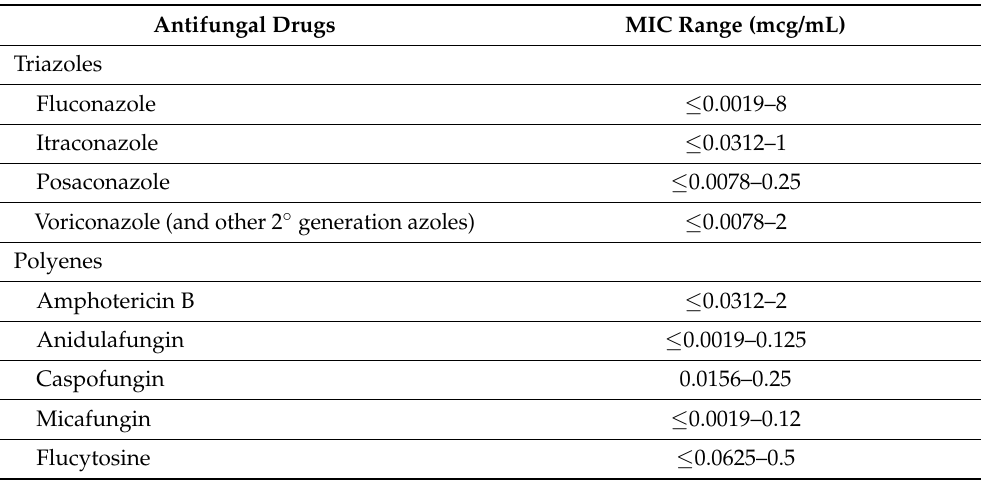
Table 3. Minimum inhibitory concentration resulted from susceptibility testing of C. auris strains isolated in Emilia-Romagna region, Italy, July 2019–December 2022 (N = 7). Antifungal